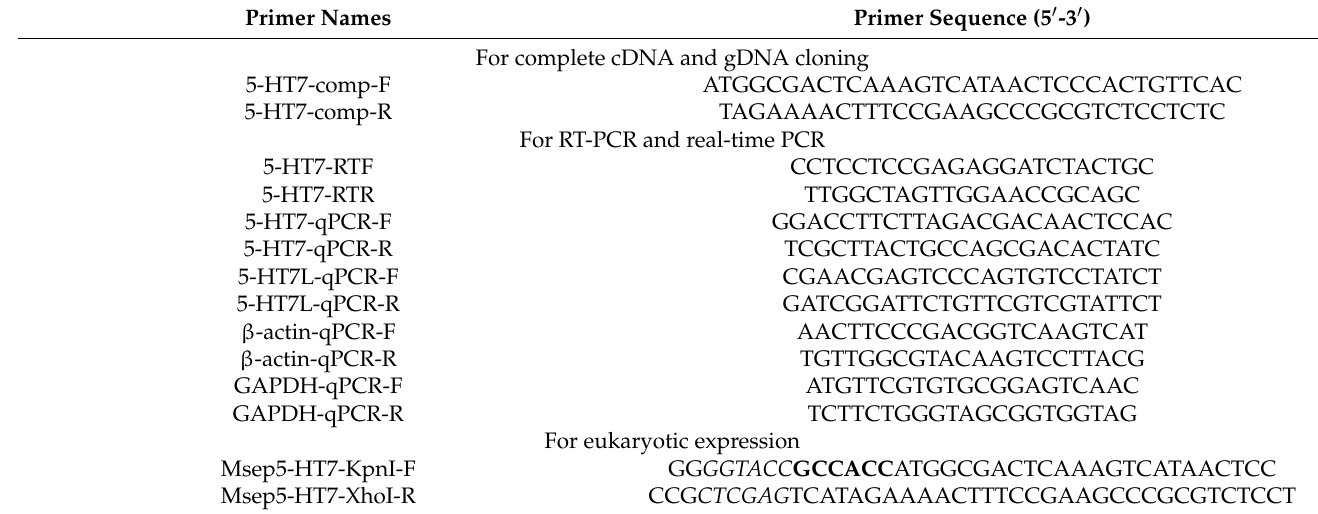
Table 4. Primers used in this